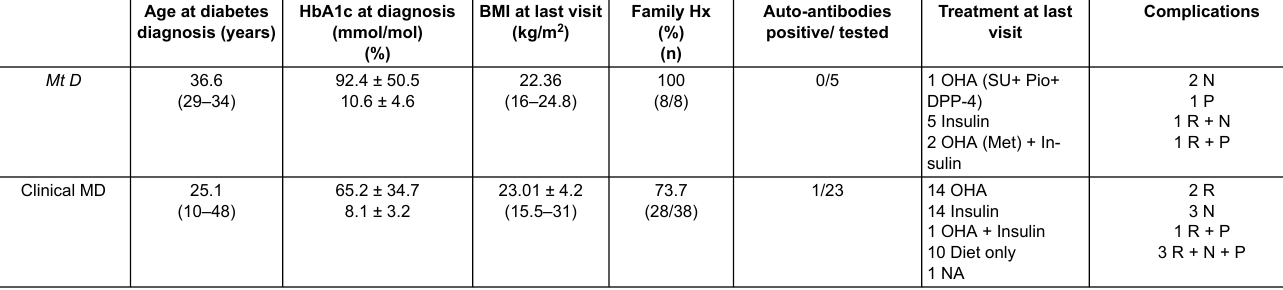
Table 2b: Subject characteristics for mitochondrial diabetes and clinical diagnosis of MD. Age at diabetes HbA1c at diagnosis BMI at last visit diagnosis (years) (mmol/mol) (kg/m 2 (%)